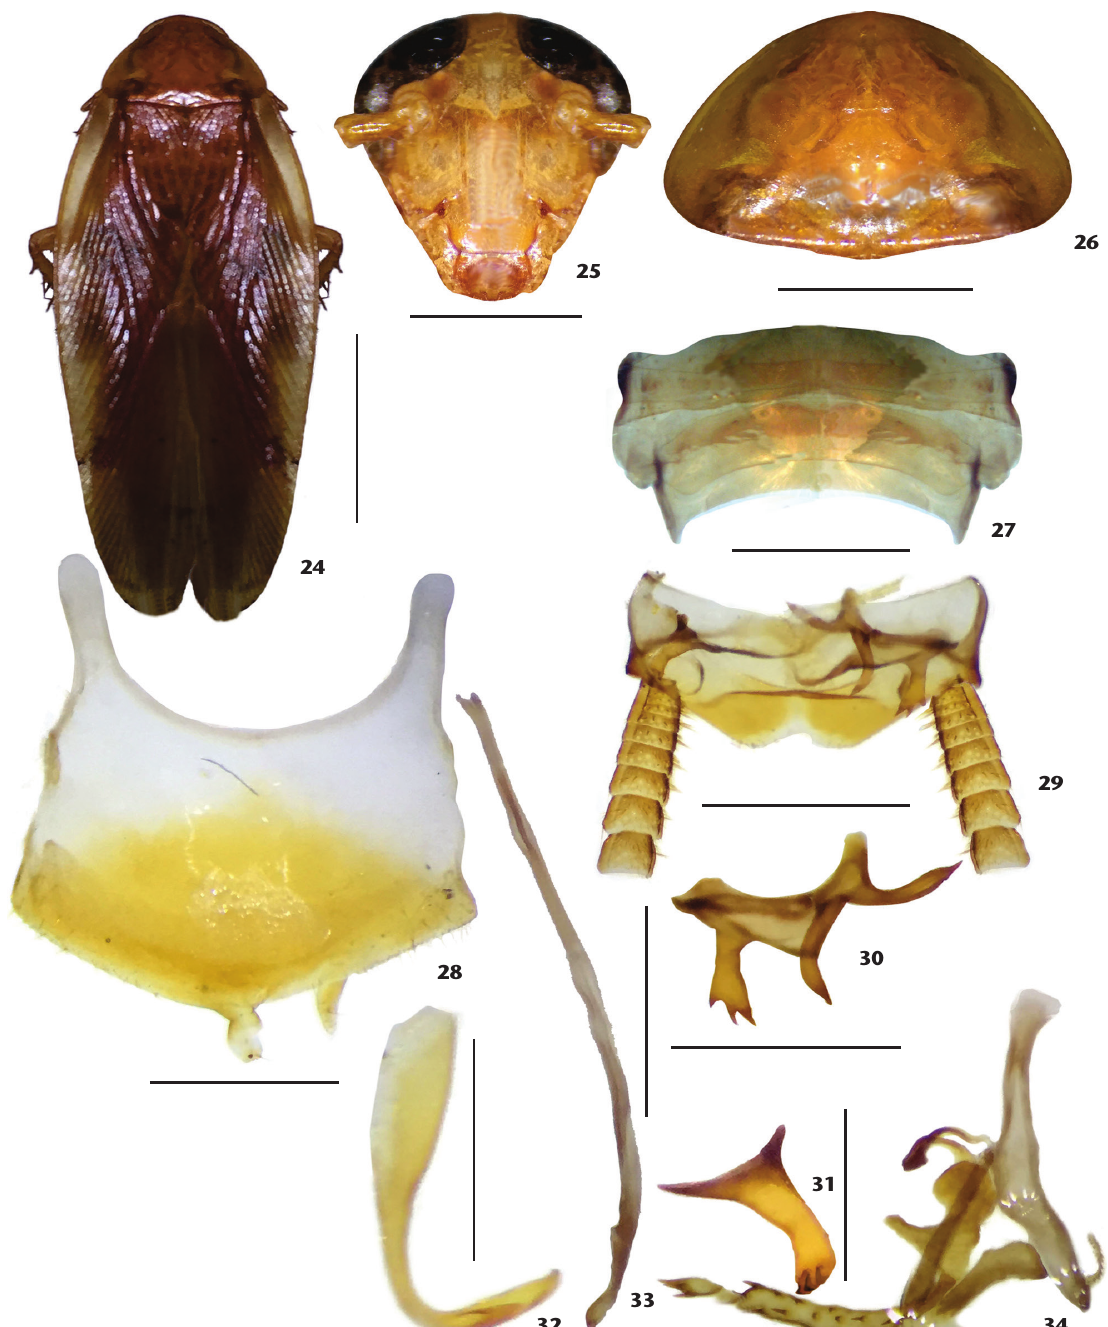
9Figures 24-34. Xestoblatta surinamensis , paratype male: (24) habitus, dorsal view, length 22.8 mm; (25) head, ventral view; (26) pronotum, dorsal view; (27) tergal modification of the tergite VII, dorsal view; (28) subgenital plate, ventral view; (29) supra anal plate, dorsal view; (30) left paraproct, dorsal view; (31) right paraproct, dorsal view; (32) left phallomere (L3), dorsal view; (33) median sclerite (L2vm), dorsal view; (34) right phallomere (R2), dorsal view. Scale bars: 25 = 7.0 mm, 26 = 2.0 mm, 27 = 3.0 mm, 28 = 1.2 mm, 29 = 1.7 mm, 30, 33 = 1.0 mm, 31 = 0.6 mm, 32 = 0.8 mm, 34 = 1.5 ZOOLOGIA 33(6): e20160041 | DOI: 10.1590/S1984-4689zool-20160041 | December 15, 20166 /